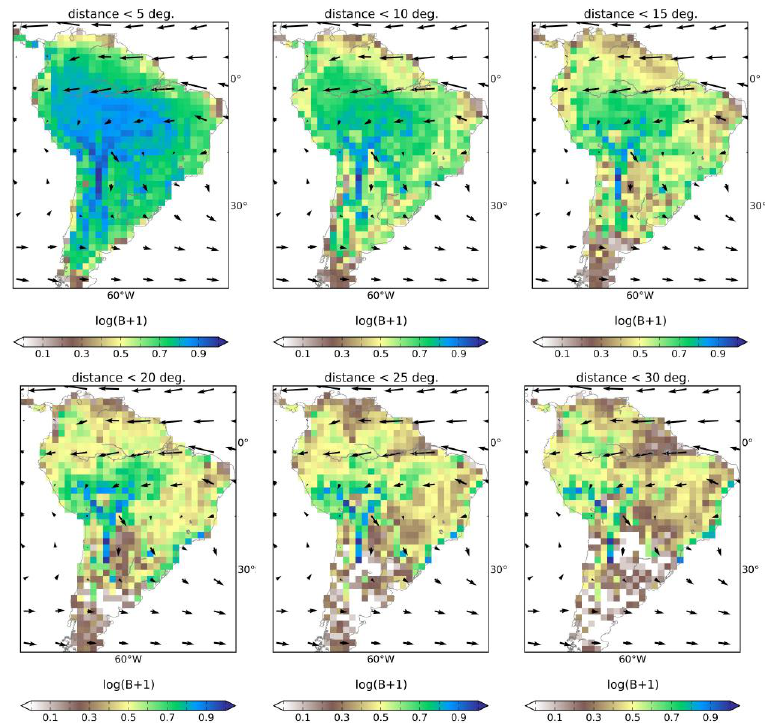
Fig. B3: Betweenness Centrality ( B ) obtained for different thresholds (yearly average for the input MOD).